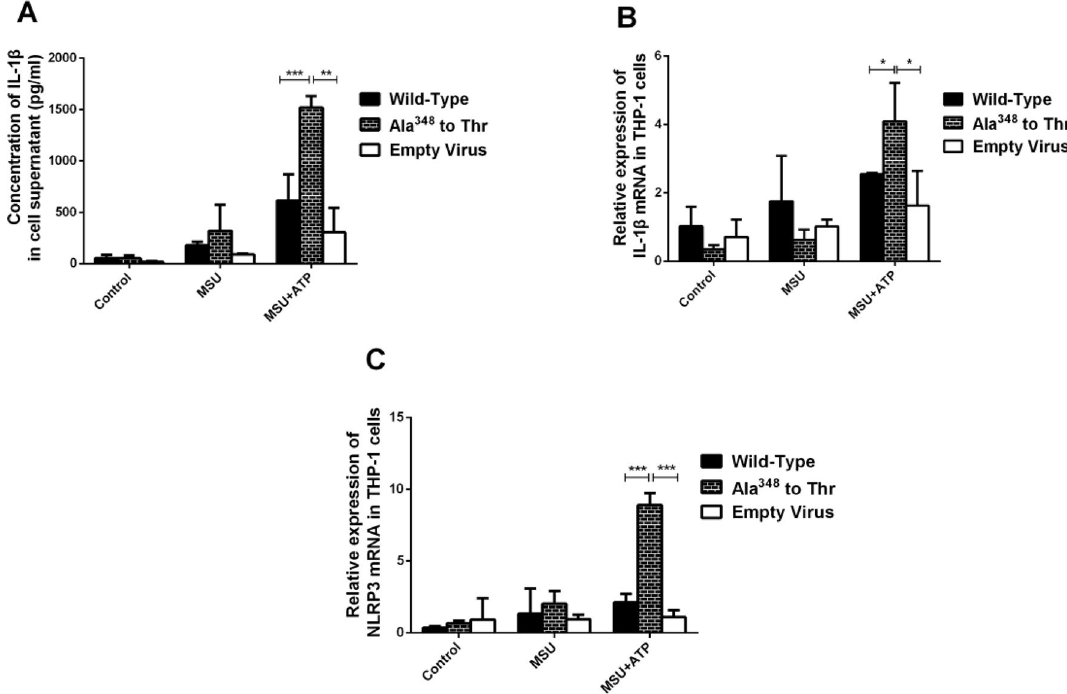
Figure 3. IL-1β and NLRP3 levels with the Ala 348 to Thr mutation. ( A ) IL-1β levels in Ala 348 to Thr, Wild -Type and Empty Virus in the supernatant. ( B ) IL-1β mRNA expression in the Ala 348 to Thr, Wild-Type and Empty Virus groups. (C) NLRP3 mRNA expression after treatment with Ala 348 to Thr, Wild-Type or Empty